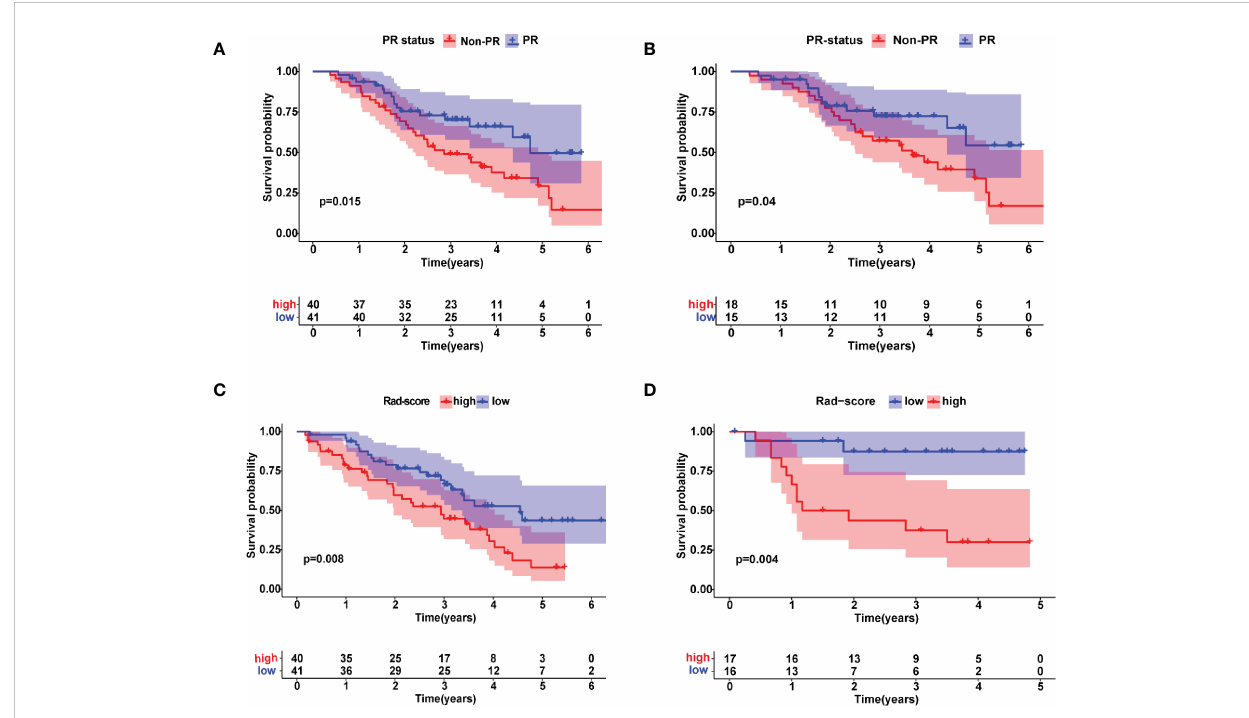
FIGURE 4 Kaplan – Meier estimates of overall survival with the associated 95% con fi dence intervals. Patients were strati fi ed by pathological response (PR) status in (A) training and (B) validation cohorts. Blue and red lines represent patients in PR and non-PR groups, respectively. Patients were strati fi ed by radiomic scores in (C) training and (D) validation cohorts. Blue and red lines represent patients in lower and higher risk groups,